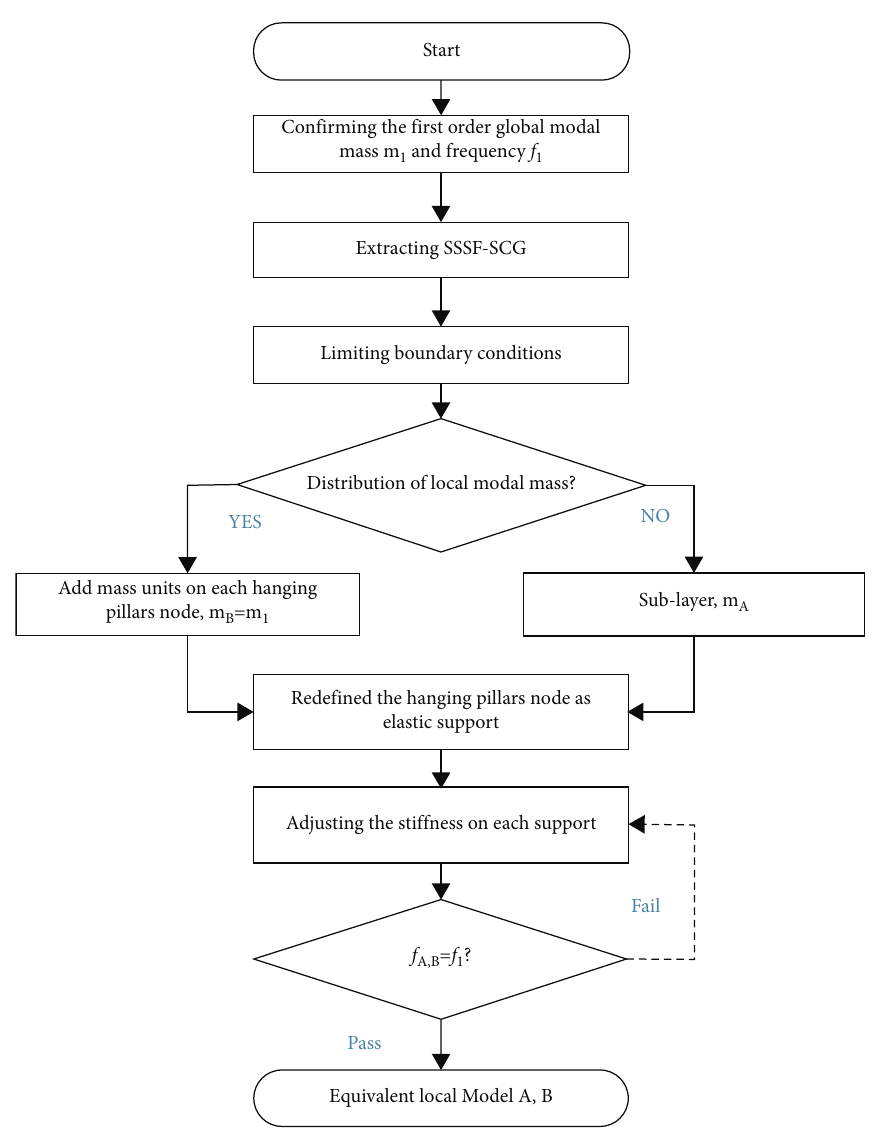
Figure 12: The flowchart of equivalent local model